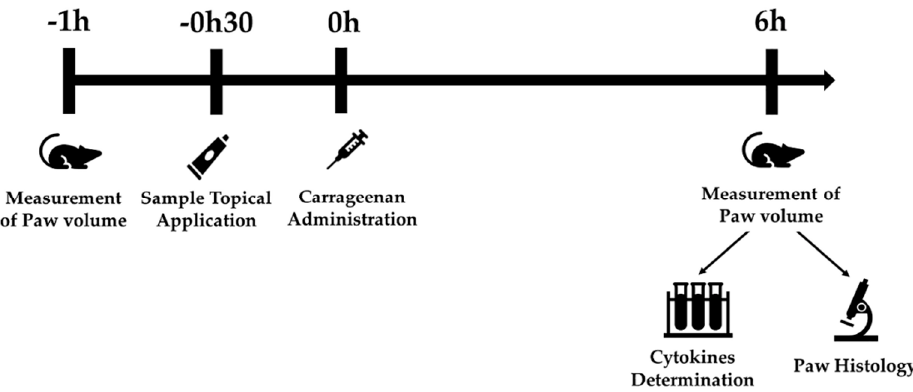
Figure 1. The experimental design of carrageenan oedema model.